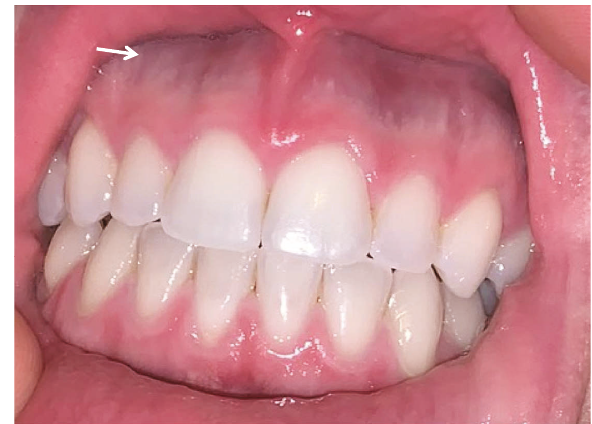
Figure 3: 2-year follow-up after discontinuation of minocycline, dark blue pigmentation is found in the maxillary gingival margins.